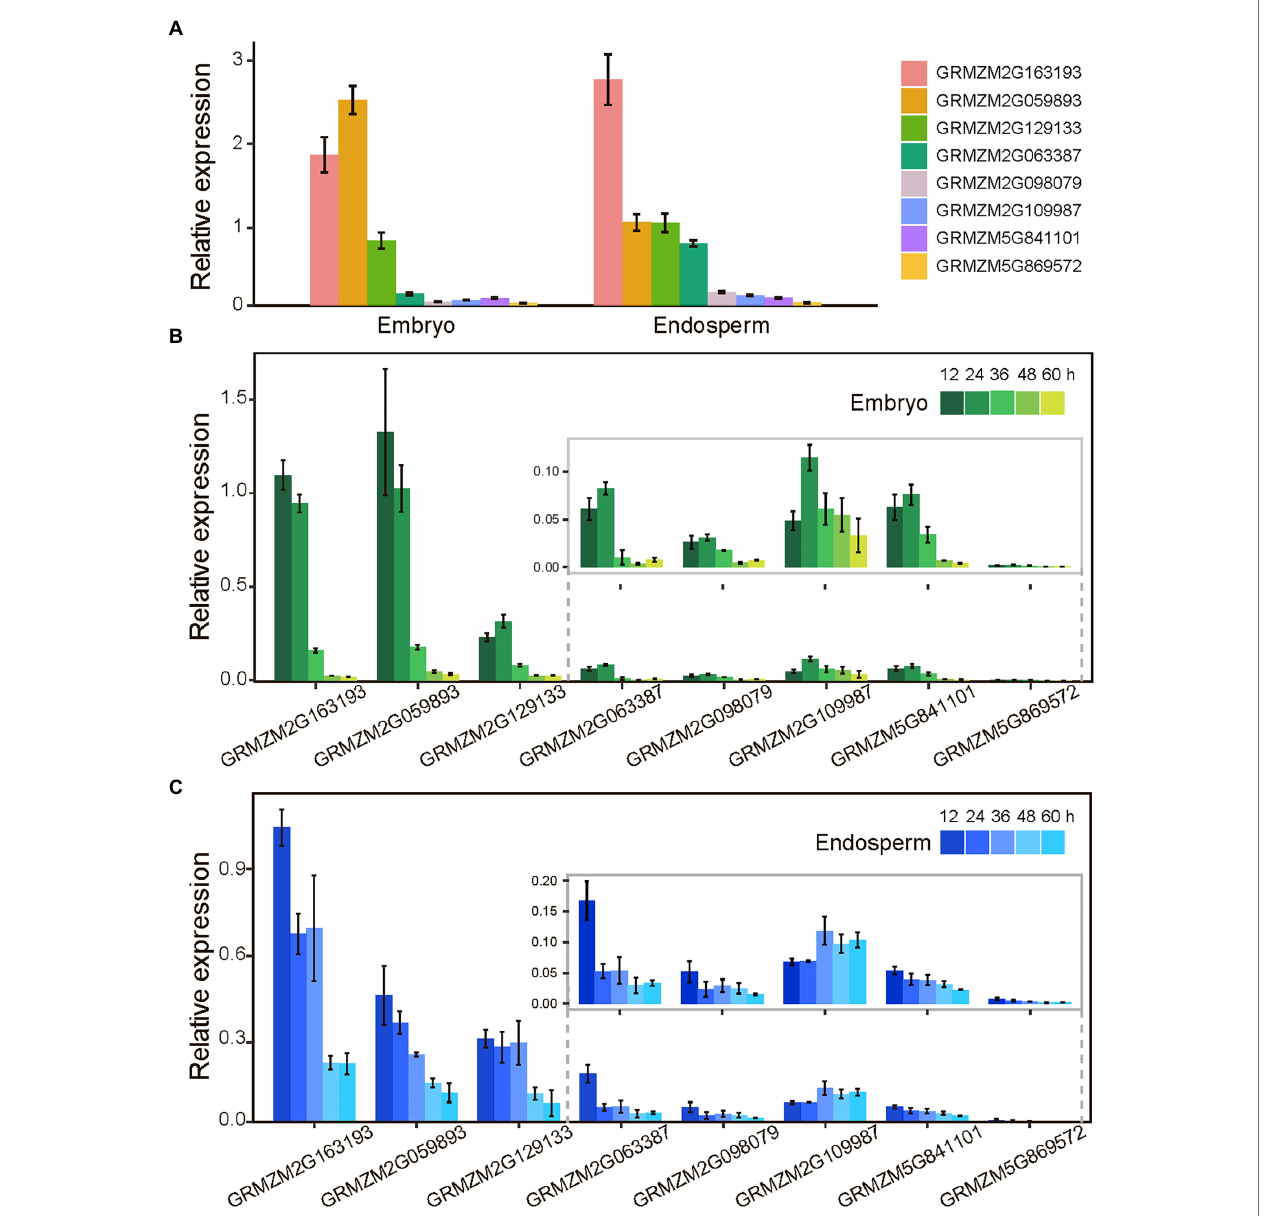
FIGURE 5 | Expression patterns of candidate genes in dry and germination seed by qRT-PCR. (A) The expression levels of candidate genes in dry embryo and endosperm. (B) Expression levels of candidate genes in the embryo of imbibition seeds. (C) Expression levels of candidate genes in the endosperm of imbibition seeds. Vertical bars indicate standard